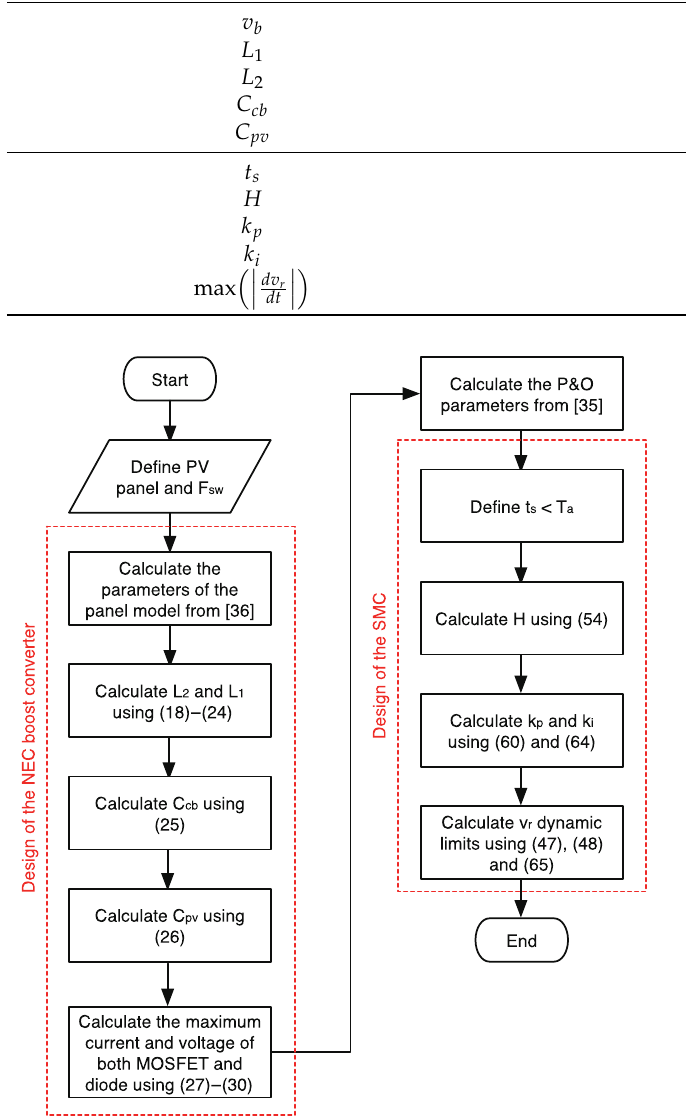
Figure 13. Design process for both the NEC boost converter and